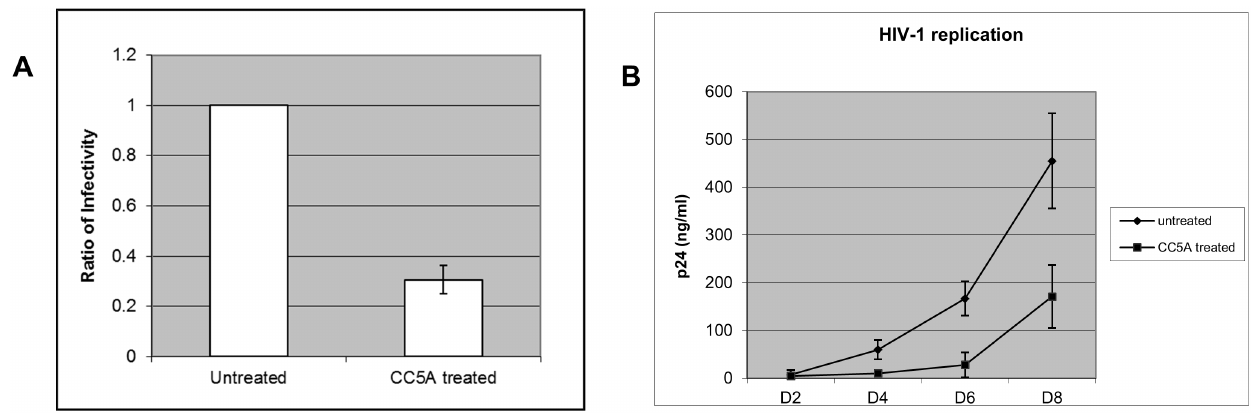
Figure 4. The active CC5A molecule inhibits HIV-1 replication. (A) THP-1/IIIB cells were treated with PBS or CC5A/PBS for 16 h. Post- treatment, THP-1 cells were washed twice by PBS and cultured for 24 h. The cells were then washed with PBS and cultured for another 24 h. The culture supernatants were collected for infectivity assays. The amount of input virus for the infectivity assay was normalized by p24 ELISA. (B) THP-1 cells were pre-treated overnight with CC5A/PBS or PBS before IIIB infection. After 3 h of infection, the cells were washed twice with PBS and put back into culture for eight days. Viral samples were collected every other day and viral replication was monitored by p24 assay.